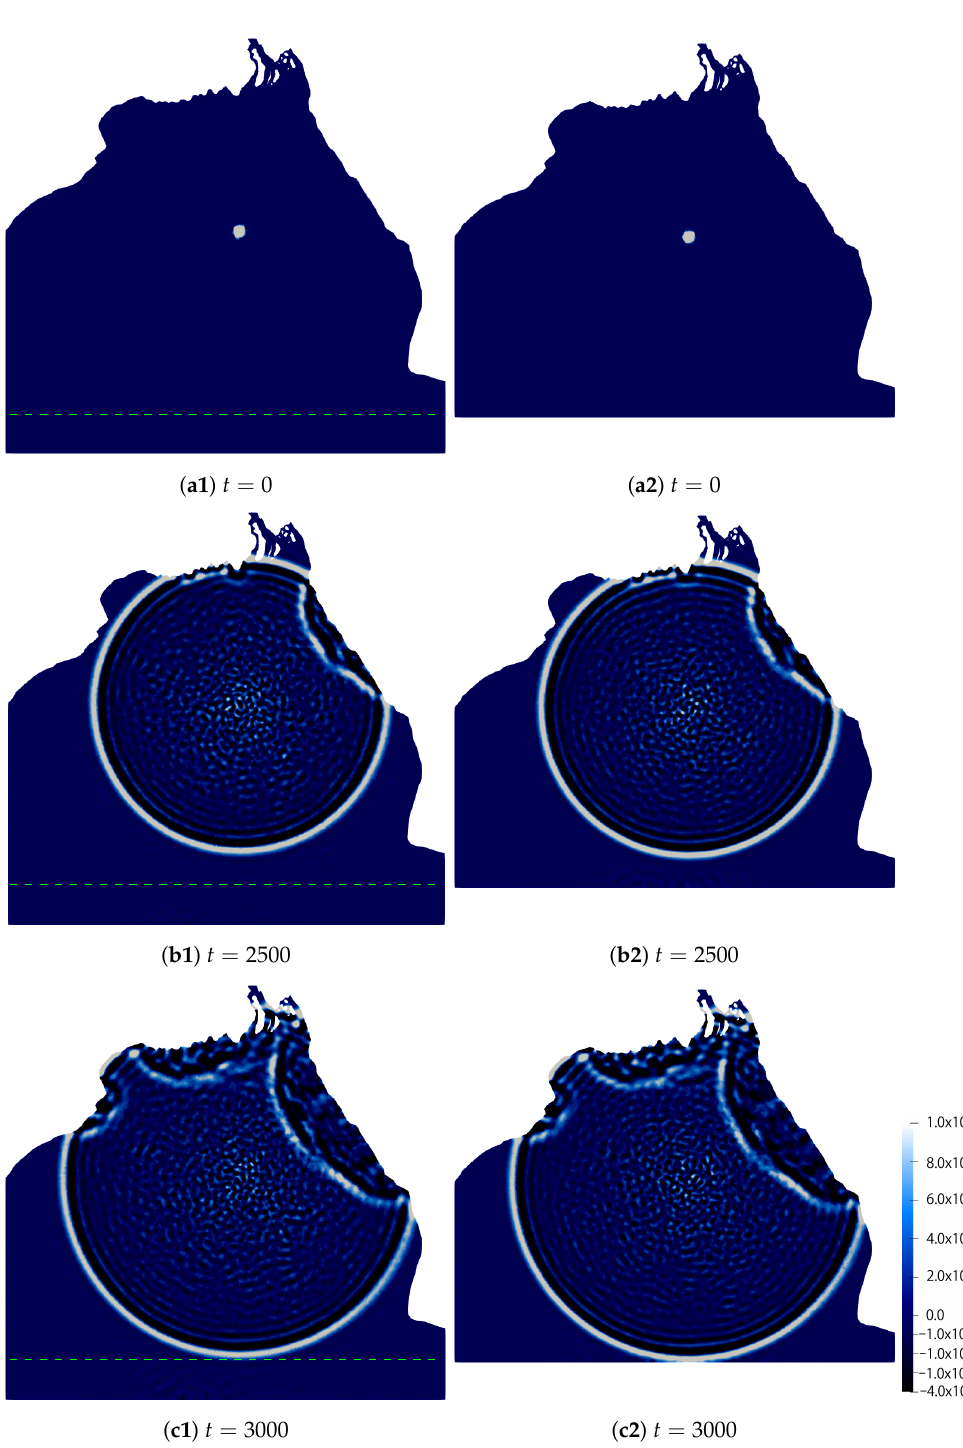
Figure 13. Contour plot of η n by LG2 with Γ = ¯ Γ D ∪ ¯ Γ T for the extended domain ( left ) and for the h original domain ( right ) on the Bay of Bengal for t = 0,2500 and 3000. The green dotted lines in the left figures indicate the position of the bottom boundary of the original